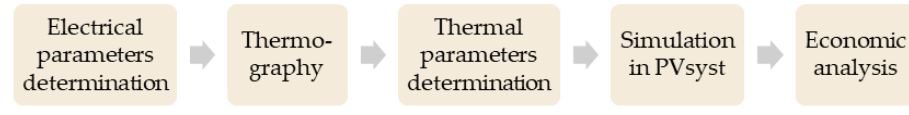
Figure 3. Summarization of methodology.